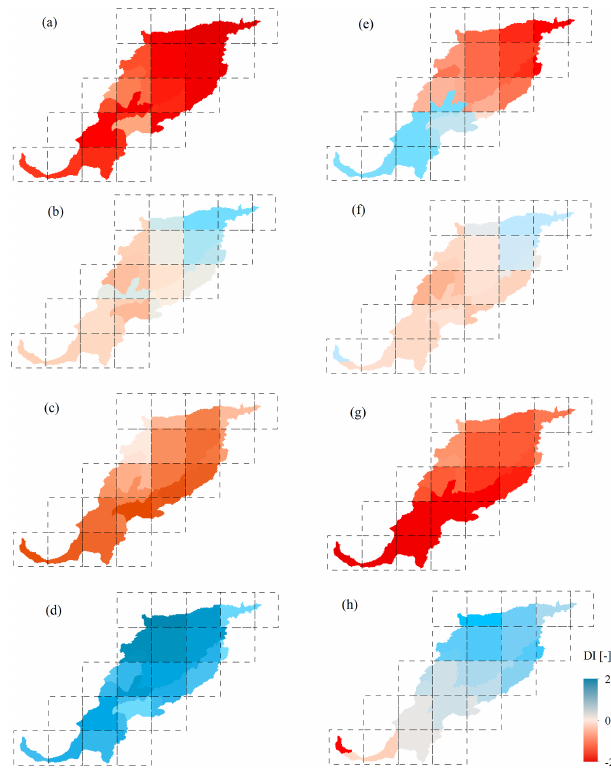
Figure 9. Spatial distribution of the (a–d) SPI and (e–h) SDI for the years 1977, 1987, 2002, and 2003, based on the grid cells of the model